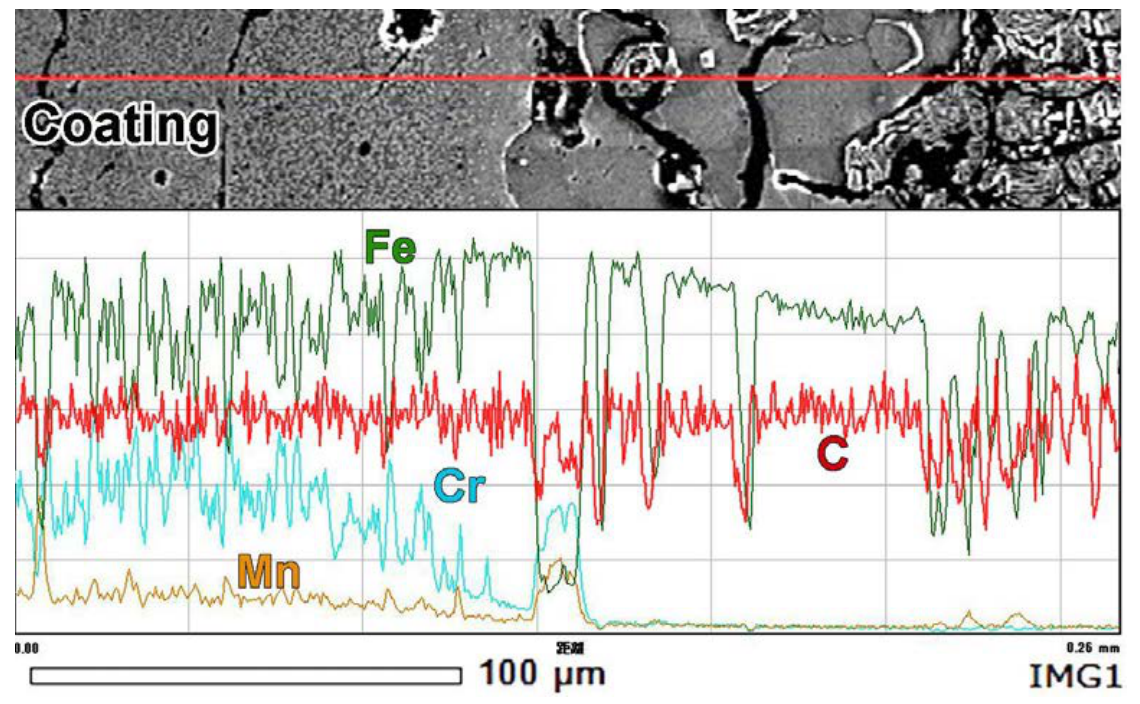
Figure 5. Cross-sectional EDS profile of Fe, Cr, Mn, and C from the coating to the substrate.